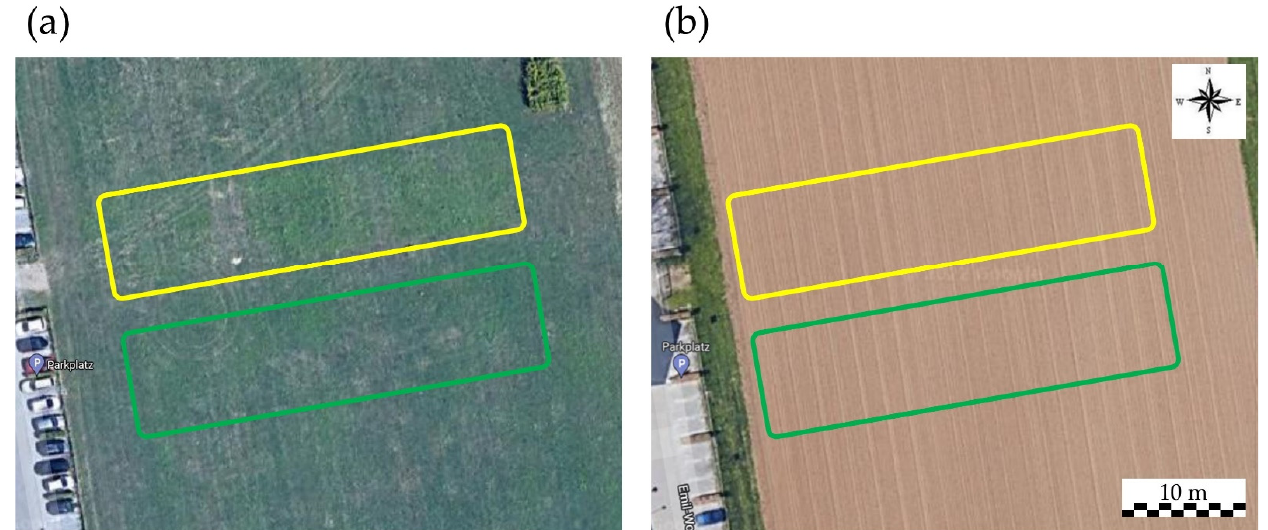
Figure 1. Satellite images (© Google Maps) of the preliminary field experiment that was carried out in this study. One image was taken before the field was ploughed in the spring of 2021 ( a ) and one was taken in the winter of 2021–2022, when winter wheat was sown but was not yet visible from space ( b ). The yellow frame indicates the area in which wild plant mixtures were grown during the years of 2013 to 2018 and the green frame indicates the area from which the maize control samples were taken in September 2021.